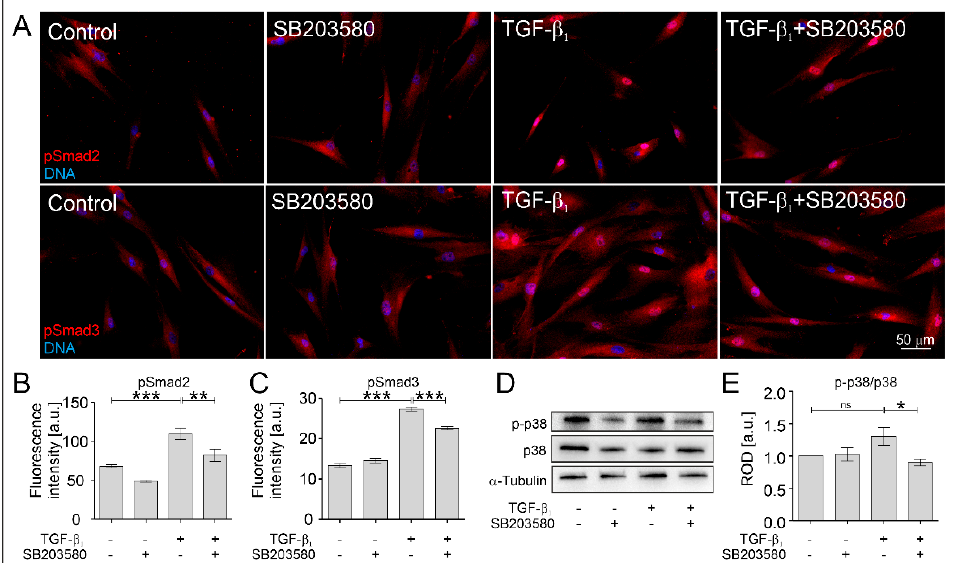
Figure 6. SB203580 affected the TGF- β 1 -induced phosphorylation levels of Smad2 and Smad3 in the cell nuclei area and diminishes the phosphorylation of p38 MAPK in HBFs AS. HBF AS populations were cultured without or with SB203580 (10 µM) in the absence or presence of TGF- β 1 (5 ng/mL) for one hour. ( A ) Representative images of HBFs AS, immunostained for pSmad2 and pSmad3 (red) and DNA (blue), were presented. Scale bar = 50 µm. ( B ) The mean fluorescence intensity (±SEM) of pSmad2 and ( C ) pSmad3 in the cell nuclei area was measured using ImageJ ( n = 3; at least 100 cells per condition). ( D ) The levels of p-p38 and p38 MAPK in HBF AS cultures ( n = 3) were determined using Western blot and quantified in ( E ). Representative membranes were shown. The statistical significance of the differences between conditions was determined by the non-parametric Kruskal– Wallis test with Dunn’s Multiple Comparison post hoc test, * p < 0.05; ** p < 0.01; *** p < 0.001; ns— not statistically significant.